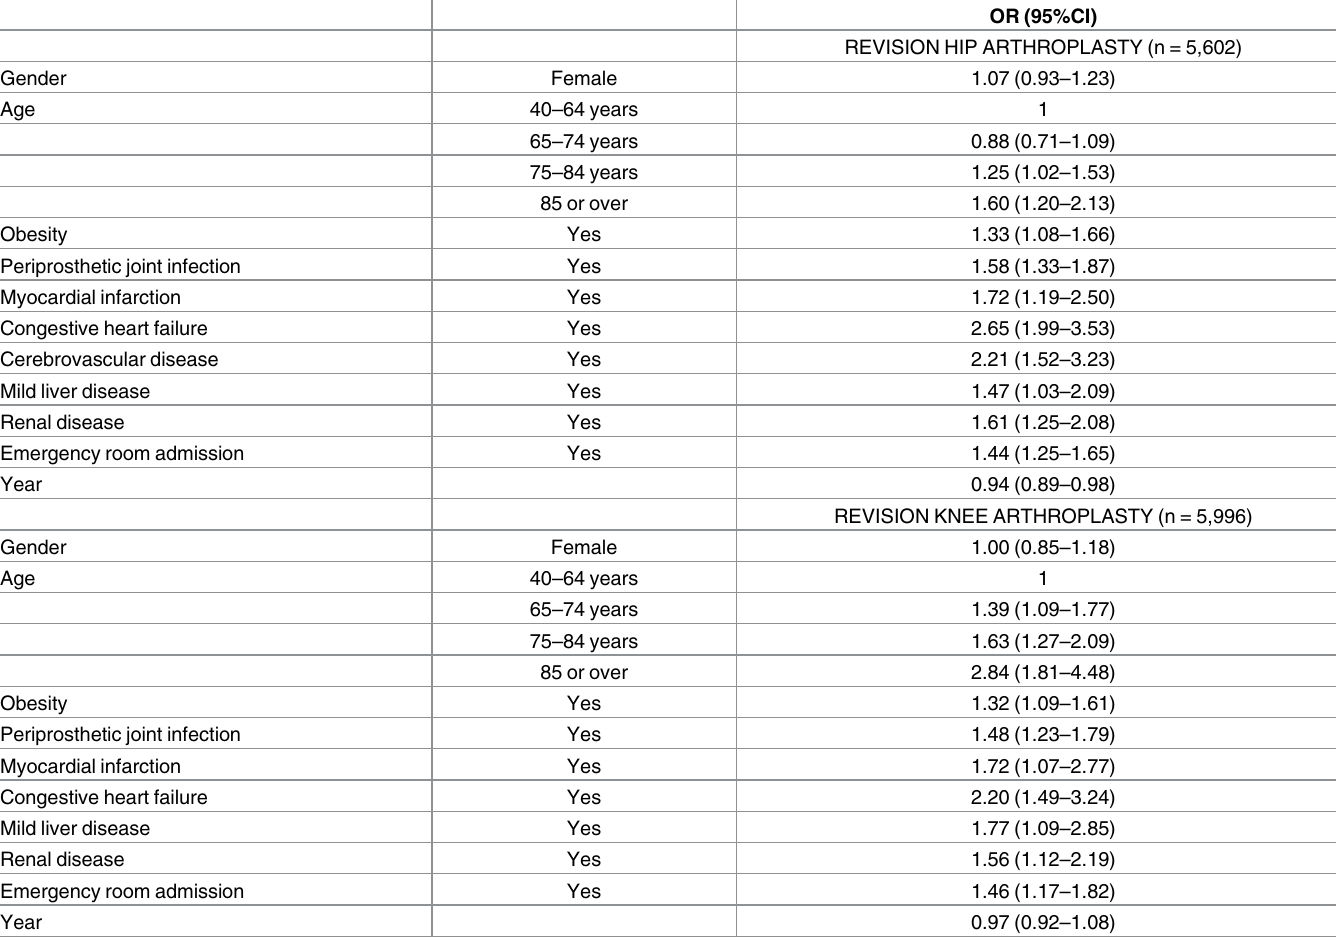
Table 5. Logistic regression analysis of the factors associated with in-hospital postoperative complications in all patients with type 2 diabetes after revision hip arthroplasty and revision knee arthroplasty in Spain